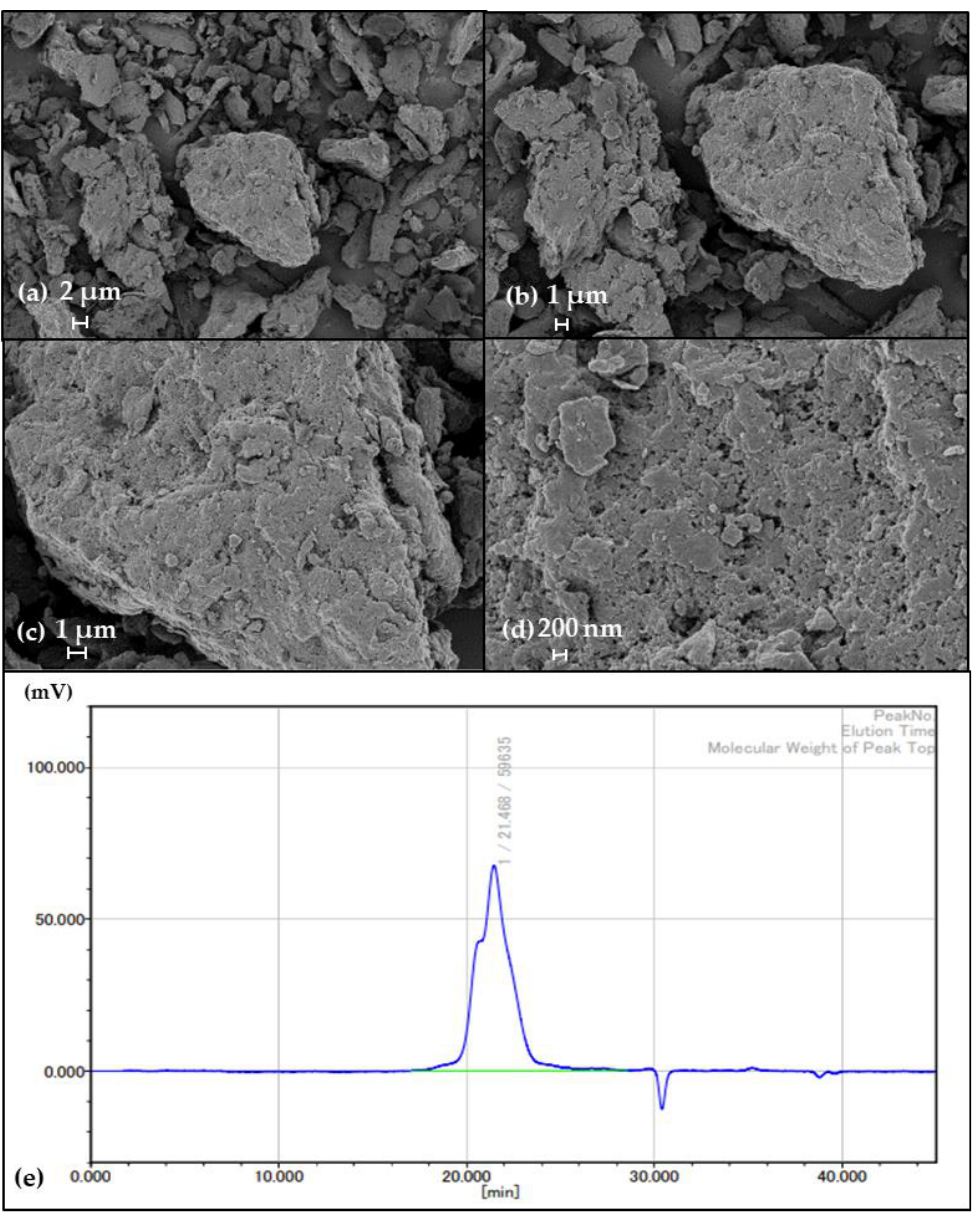
Figure 3. SEM images of purified lyEPS. The magnifications of the SEM images are ( a ) 3000 × , ( b ) 5000 × , ( c ) 10,000 × , and ( d ) 30,000 × ; ( e ) Mw distributions of